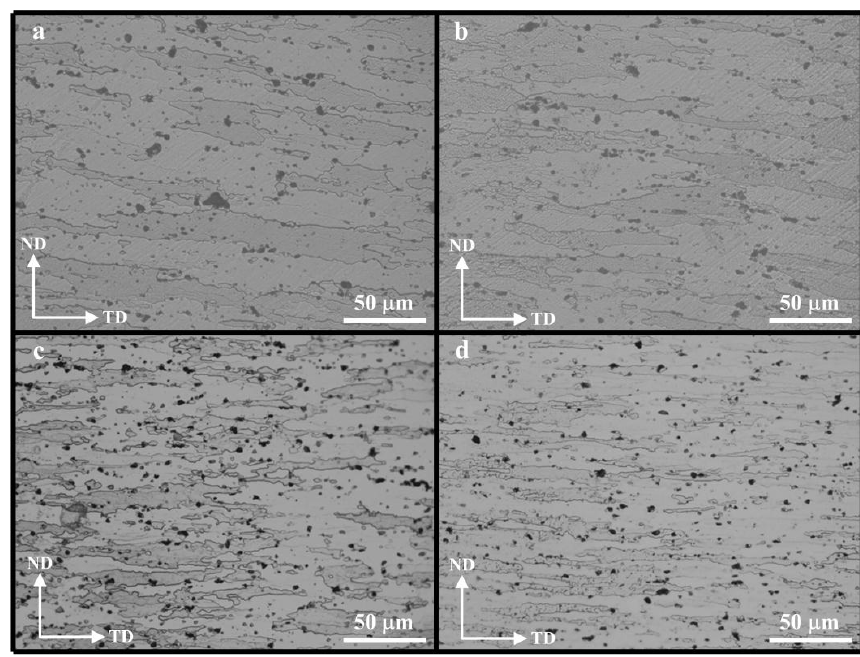
Figure 3. OM microstructures of ND-TD surface for 7075 T6 alloy without and with different contents of Sr addition: ( a ) 0 wt. % ; ( b ) 0.05 wt. % ; ( c ) 0.1 wt. % ; and ( d ) 0.2 wt. % Sr.